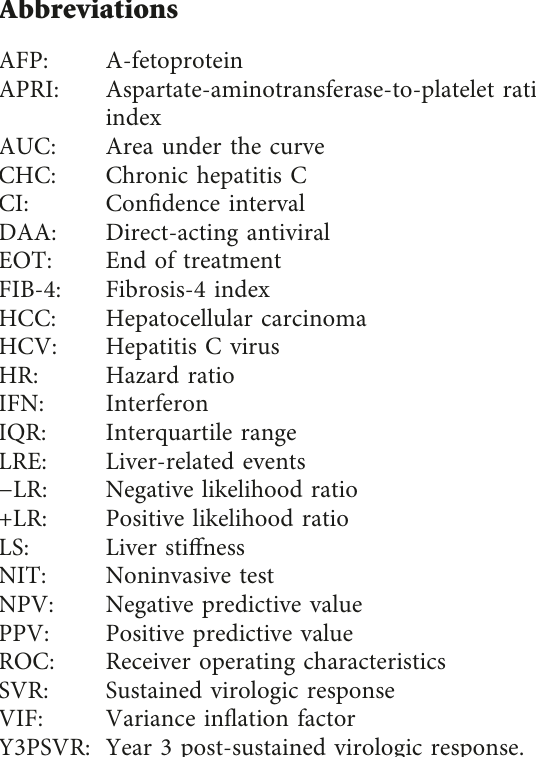
Figure S1. Single decision tree classifier preliminarily trained to assist in predictor identification. Figure S2. ROC curves for LRE classification with single decision tree and ensemble random forest classifiers. Table S1. Comparison of baseline characteristics between patients without ( n � 457) and with ( n � 63) clinical cirrhosis. ( Supplementary Materials